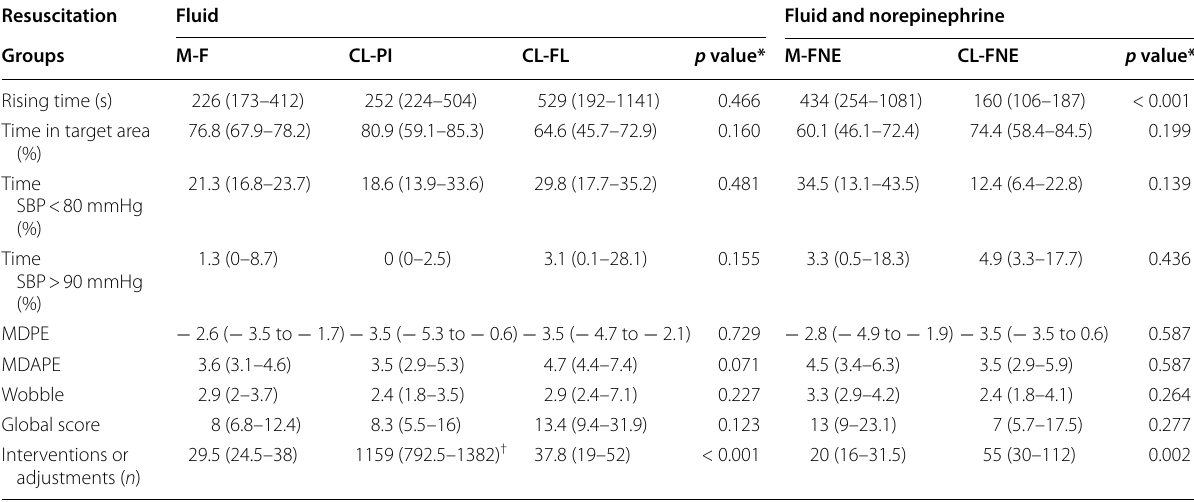
Data are presented as median [interquartile range (lower quartile to upper quartile)] M - F manual fluid, CL - PI closed-loop using a PI algorithm, CL - FL closed-loop using a FL algorithm, M - FNE manual fluid and norepinephrine, CL - FNE closed-loop administration of fluid and norepinephrine, SBP systolic arterial pressure, MDPE median performance error, MDAPE median absolute value of performance error * p value is for Kruskal–Wallis test; ** p value is for Mann–Whitney test; † p < 0.0001 in Dunn’s multiple comparisons versus